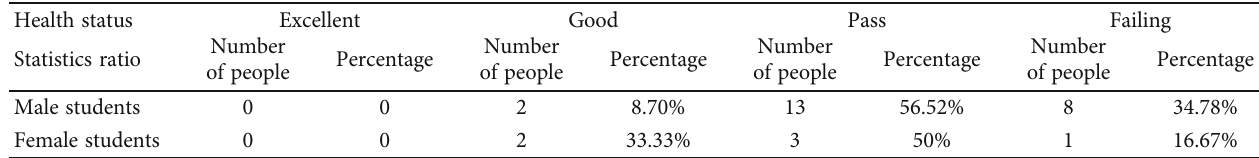
Table 6: Students ’ comprehensive physical health evaluation status.